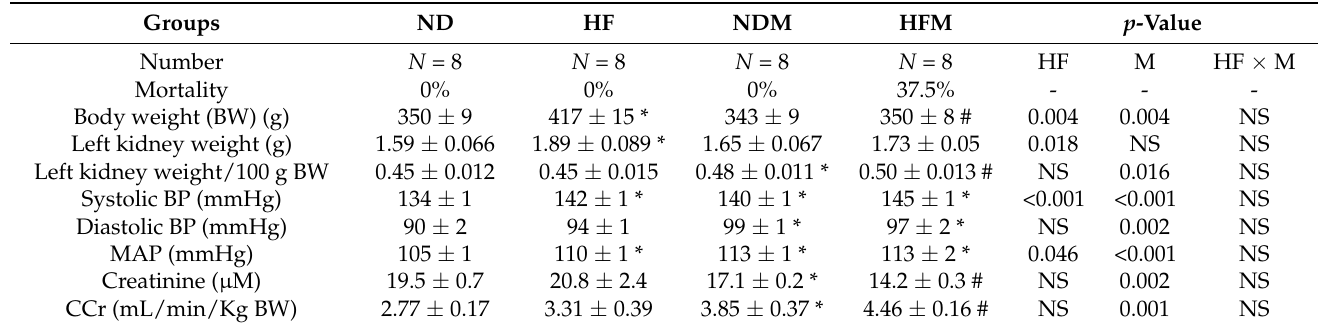
Table 1. Morphological and biochemical